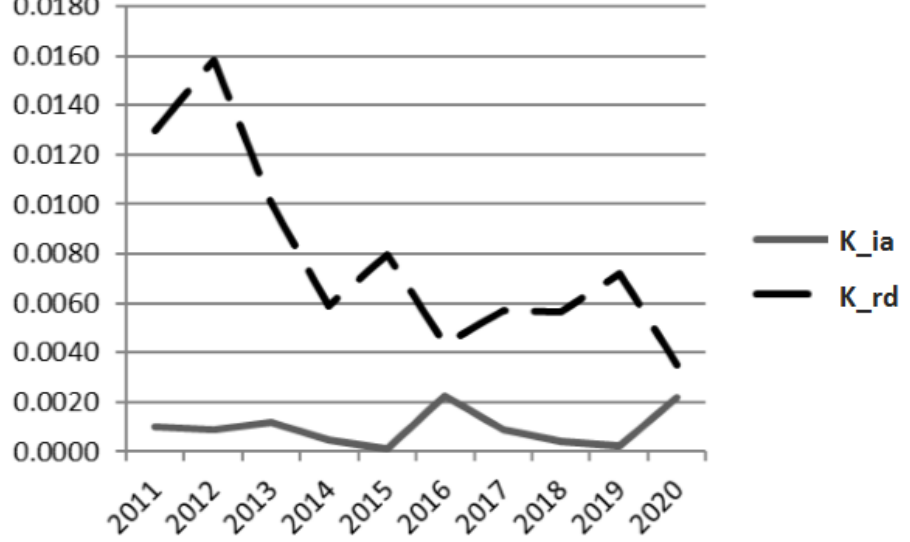
Figure 18. Coefficient of the intangible assets (K_ia) and R&D costs (K_rd) for Freeport-McMoRan Inc.